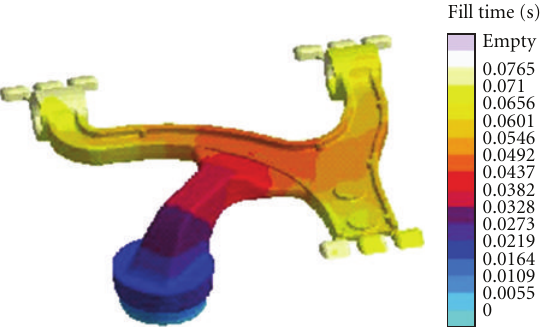
Figure 3: Filling time distribution of arm part.